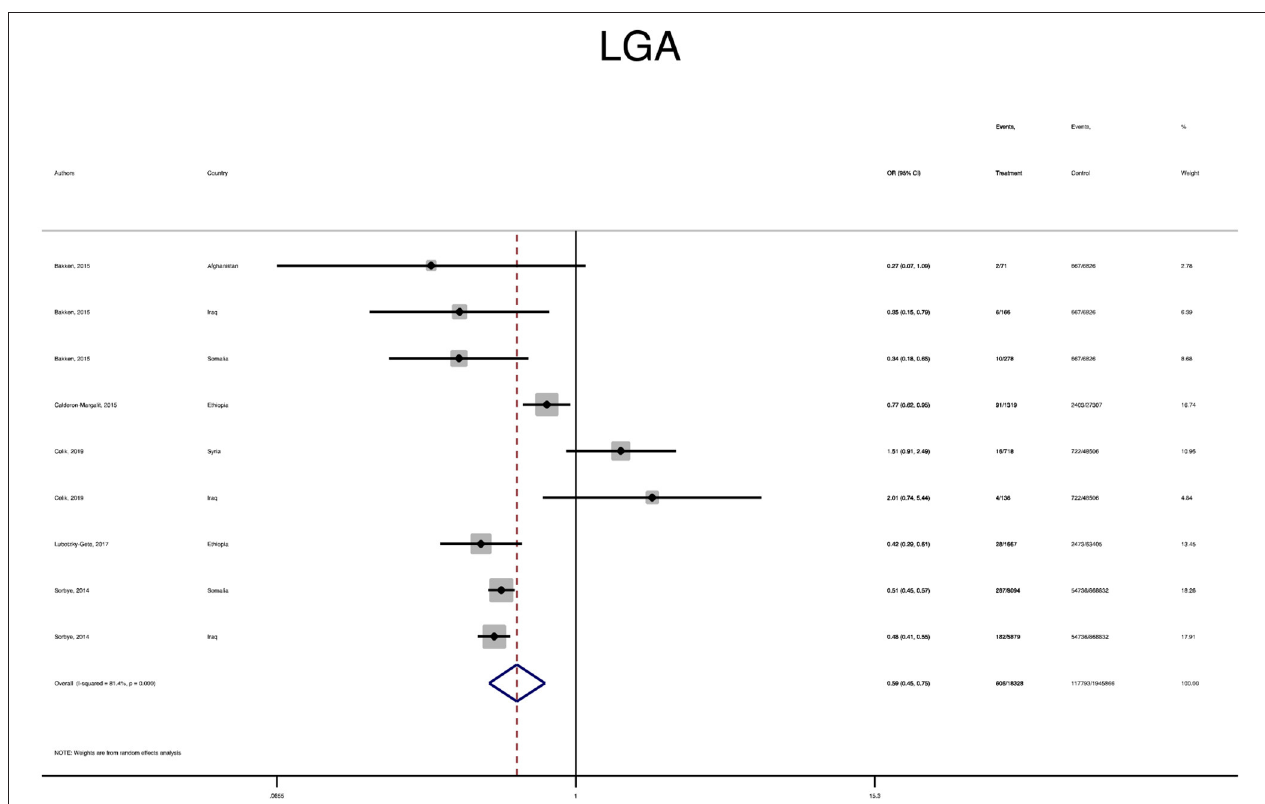
FIGURE 7 | A forest plot of the pooled odds ratio of large for gestational age (LGA) in the immigrant and native-origin